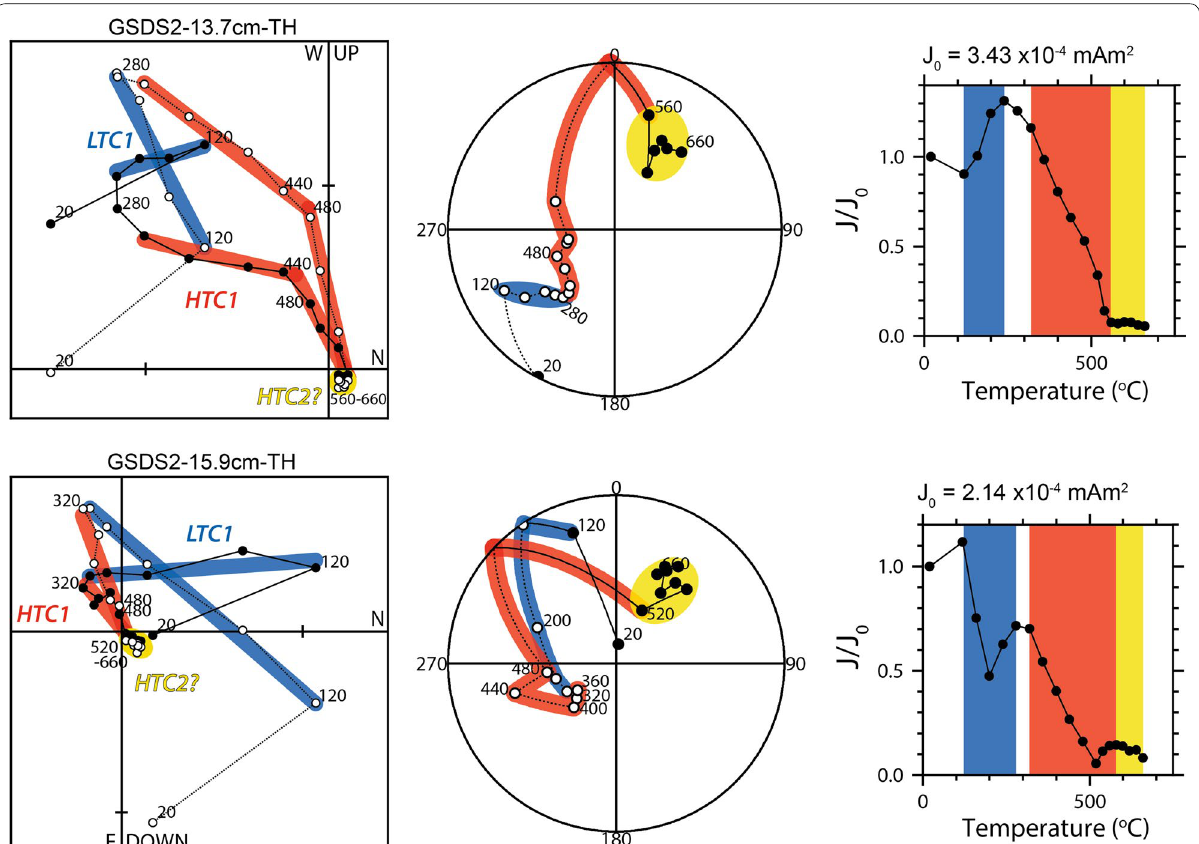
Fig. 5 Zijderveld diagrams (left), equal‑area projections (middle), and intensity decay curves (right) of TH demagnetization results of NRMs for two specimens (13.7 and 15.9 cm depth of the GSDS2 profile; 14.8 and 17.0 cmcd, respectively (see text for the cmcd definition)) showing apparently anti‑parallel directions between remanences before and above ~ 520–560 °C (see text for